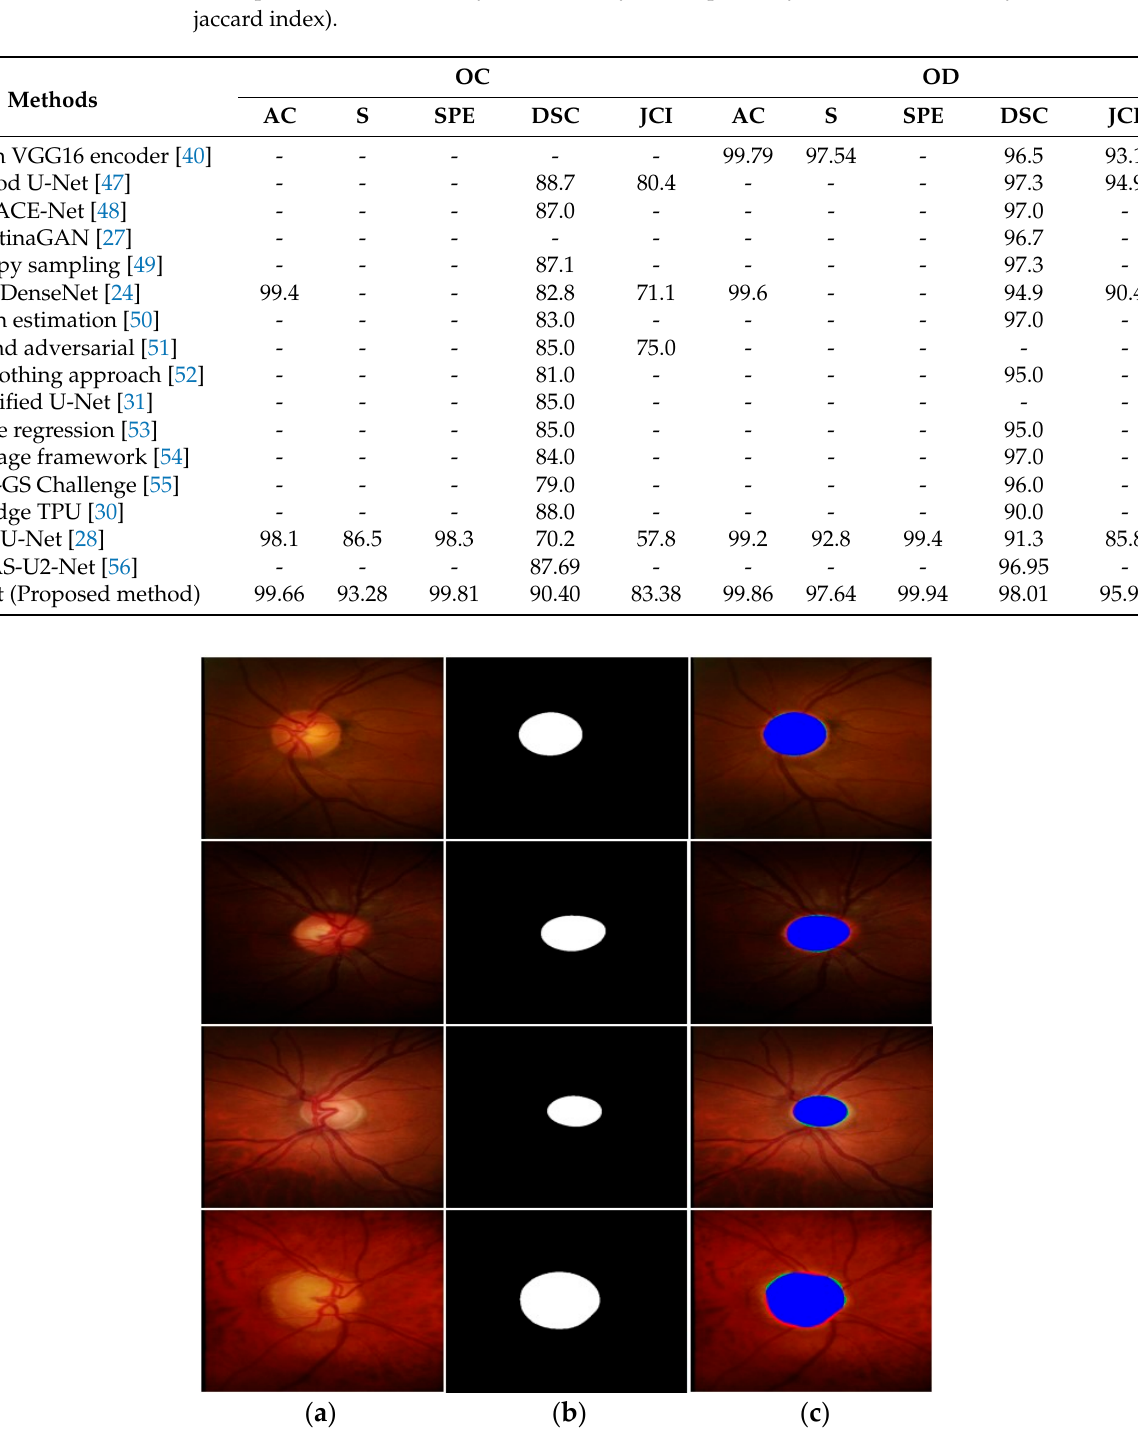
Table 2. Segmentation quantitative results comparison of FEDS-Net with state-of-the-art methods using the Drishti-GS database. “-” indicates that no result is available (unit: %). (OC: optic cup; OD: optic disc; AC: accuracy; S: sensitivity; SPE: specificity; DSC: dice similarity coefficient; JCI: